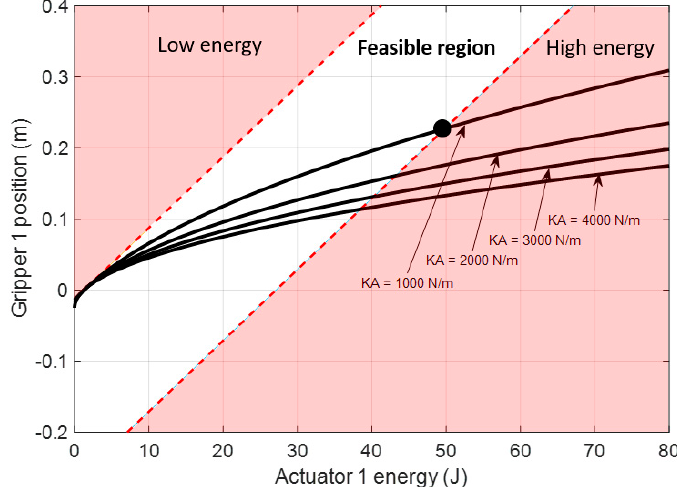
The aperture of this second gripper can be set by imposing the corresponding values in the nullspace.